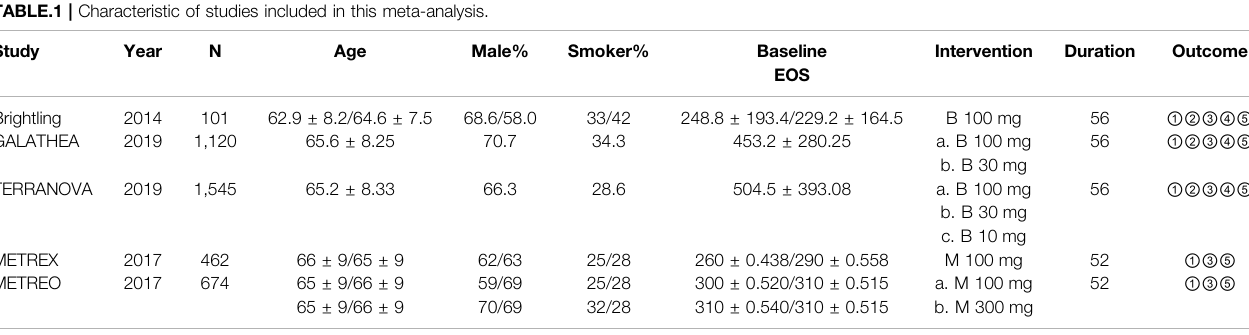
Outcome: ① annual rate of acute exacerbation; ② change from baseline of pre-bronchodilator FEV 1 ; ③ change from baseline of SGRQ total score; ④ hospital admission rate for acute exacerbation; ⑤ severe adverse events. B: benralizumab; M: